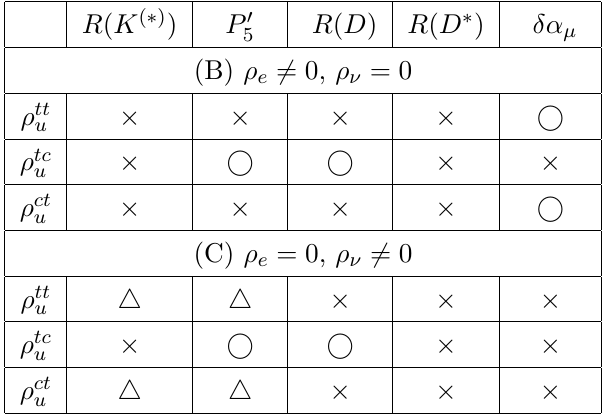
Table 5 . Summary of the capabilities to explain the excesses. In the each observable, our prediction is evaluated by the symbols, \ (cid:13) ", \ 4 " and \ (cid:2) ". The meanings are explained in the text. compatible with the solutions to the ( g (cid:0) 2) and R ( K ( (cid:3) ) ) anomalies. This is because the (cid:22) charged Higgs that couple to b , c and (cid:22) largely violate the lepton universality of B ! D ( (cid:3) ) l(cid:23)